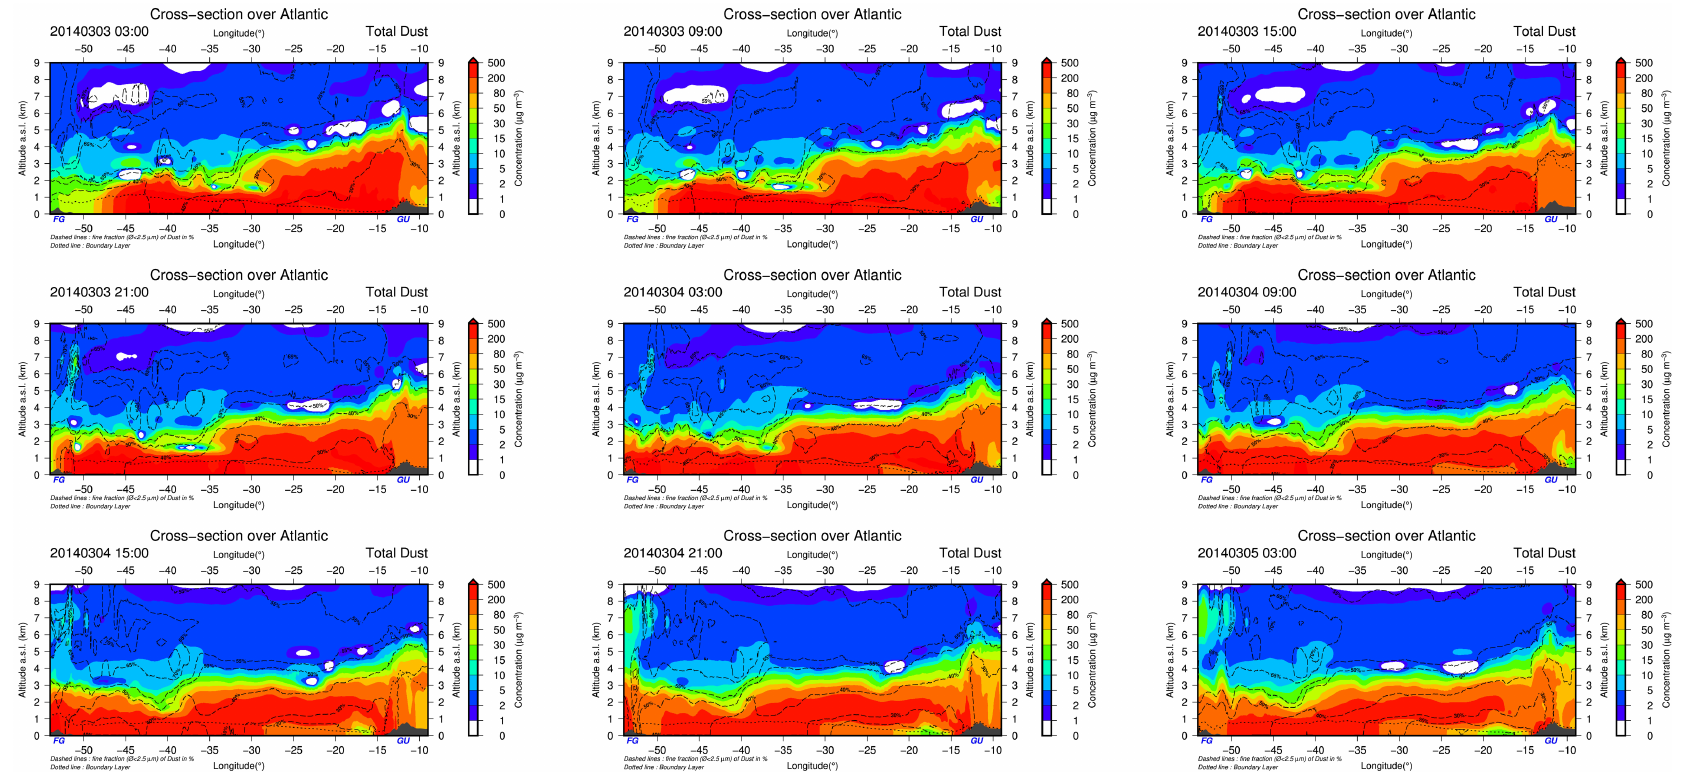
Figure 18. Arrival of the main dust episode over South America. Cross section of total dust concentrations fields (Altitude versus Longitude from) from Africa (GU for Guinea 11 ◦ N) to South America (FG for French Guiana 3 ◦ N) from 3 March 03:00 UTC to 5 March 03:00 UTC. The dotted line represents the height of the boundary layer, the dashed lines represent the fraction of fine dust in